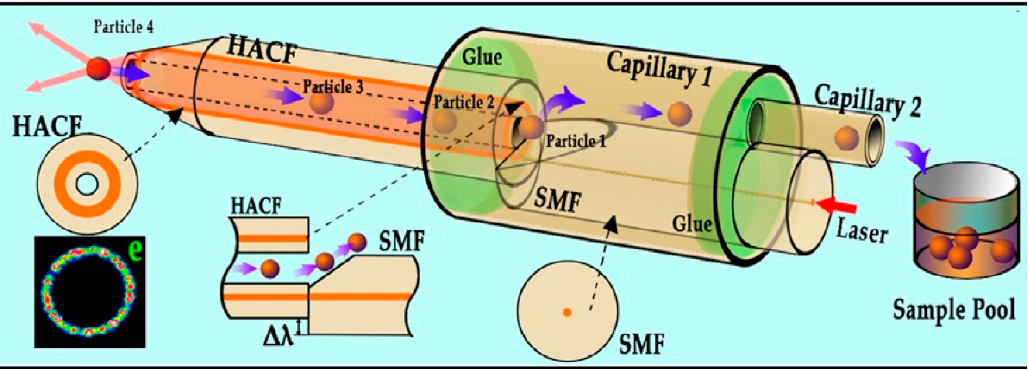
Figure 13. Schematic diagram of optical manipulation based on the hollow annular-core fiber taper (HACF) [66].